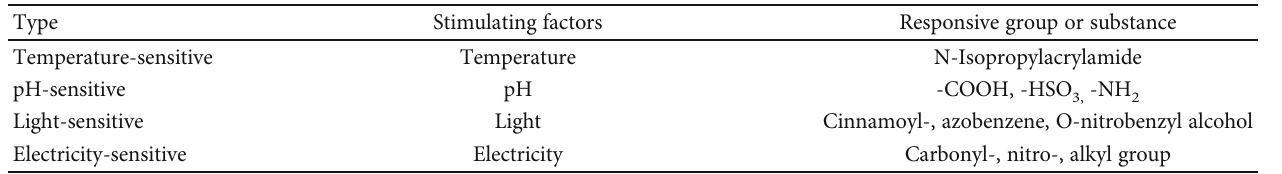
Figure 2: Schematic illustration of the fabrication process of IPN hydrogels. Table 1: Stimulating and responsive factors of smart